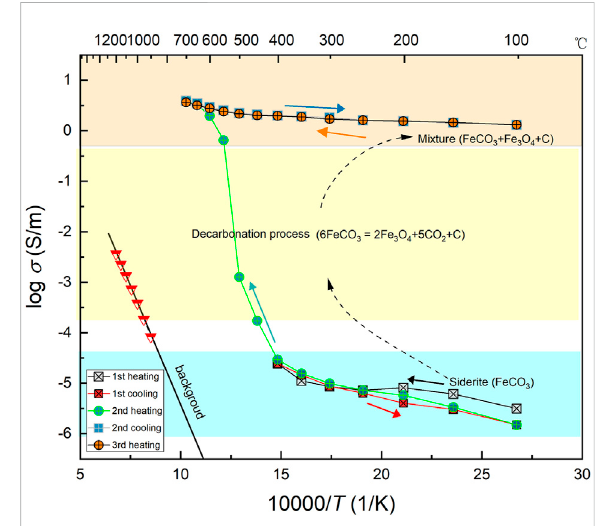
FIGURE 2 The electrical conductivityof sample in thedifferentheating- cooling cycles at 3 GPa, together with the conductivity of background in sample cell. The distinct variation in conductivity was observed in the second heating cycle, in which the decarbonation reaction of sample took